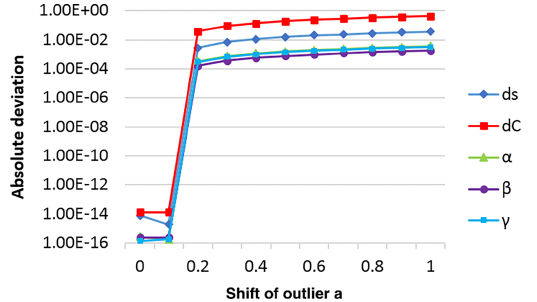
Figure 7. Deviation between the calculated flange fit and the ref- erence solution for a simulated outlier point in the extracted plane data